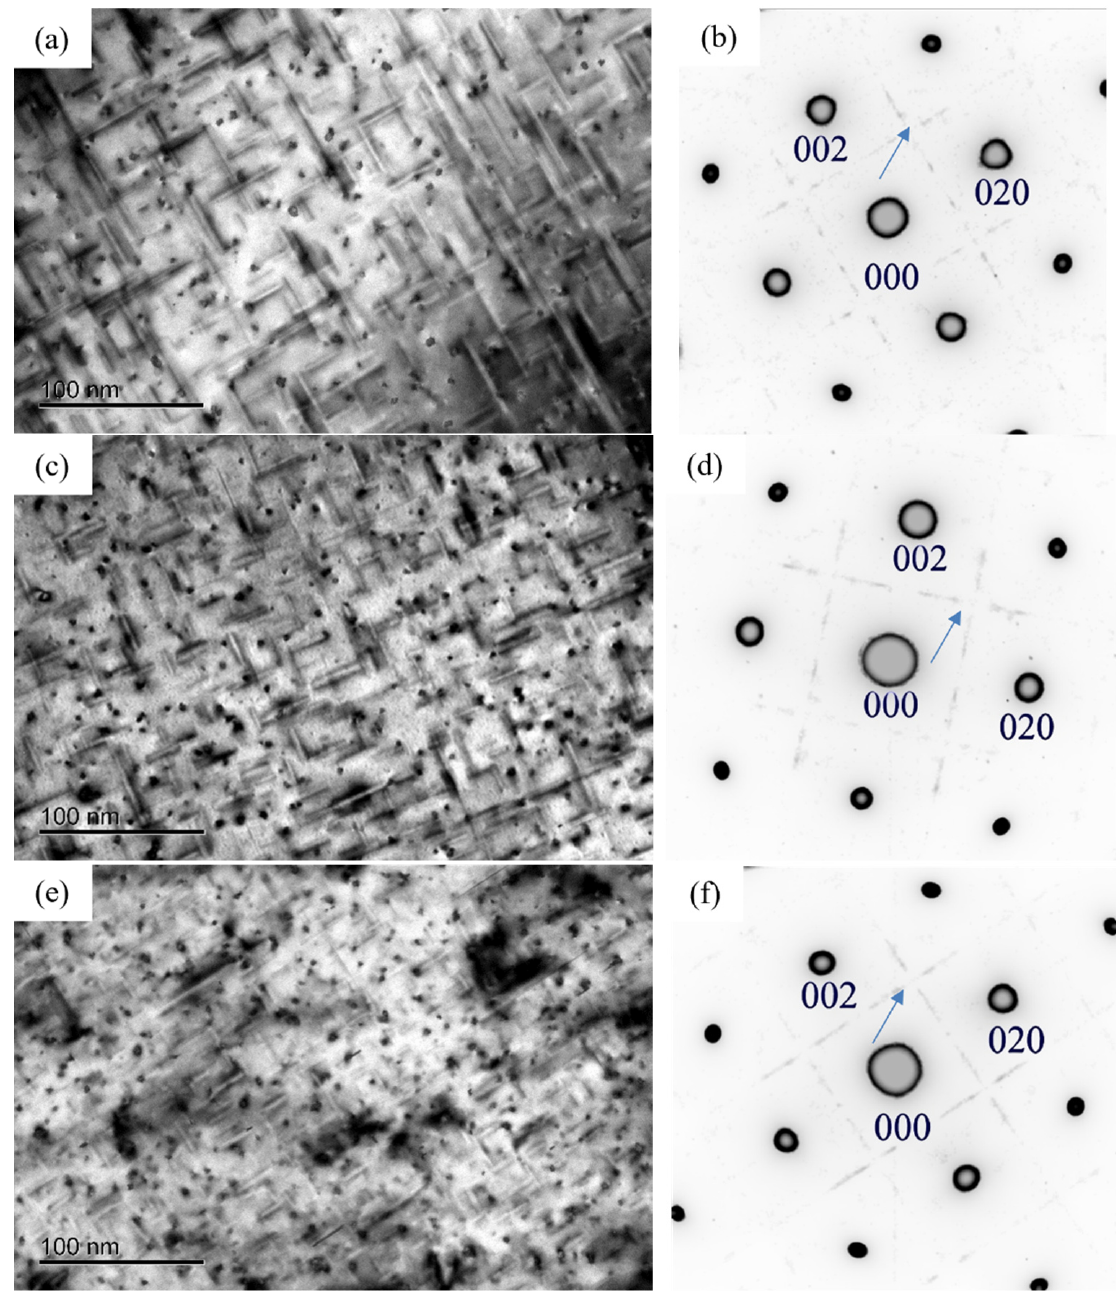
Figure 8. BF image and SAED patterns after peak aging of three alloys. ( a , b ) 0Cu alloy; ( c , d ) 0.18Cu alloy; ( e , f ) 0.37Cu alloy.